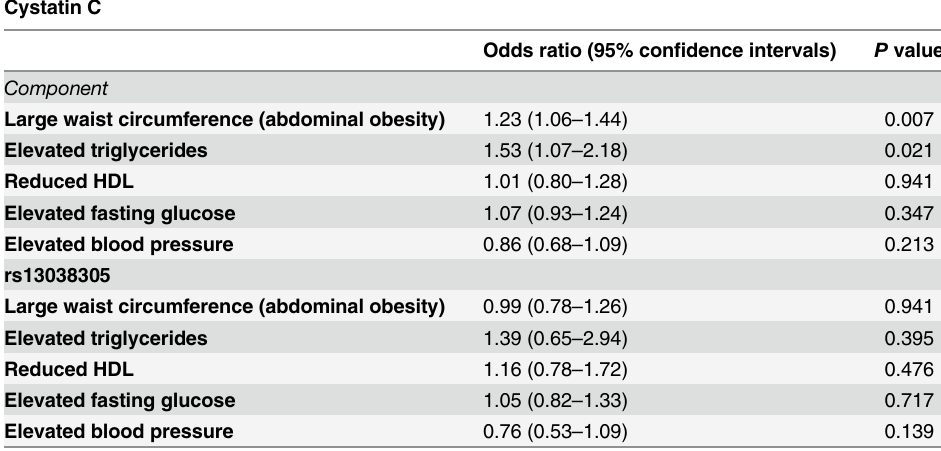
Table 3. Cystatin C and rs13038305 and incidence of the individual components of the metabolic syn- drome in the MDC-CC-re-examination-replication-cohort. Cystatin C